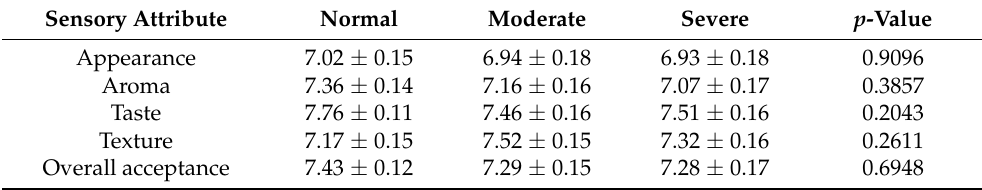
Table 6. Sensory scores of fresh sausages produced with breast meat from Ross (AP95) broiler chickens without myopathies and affected by wooden breast myopathy, obtained in a sensory test with untrained tasters using a nine-point hedonic